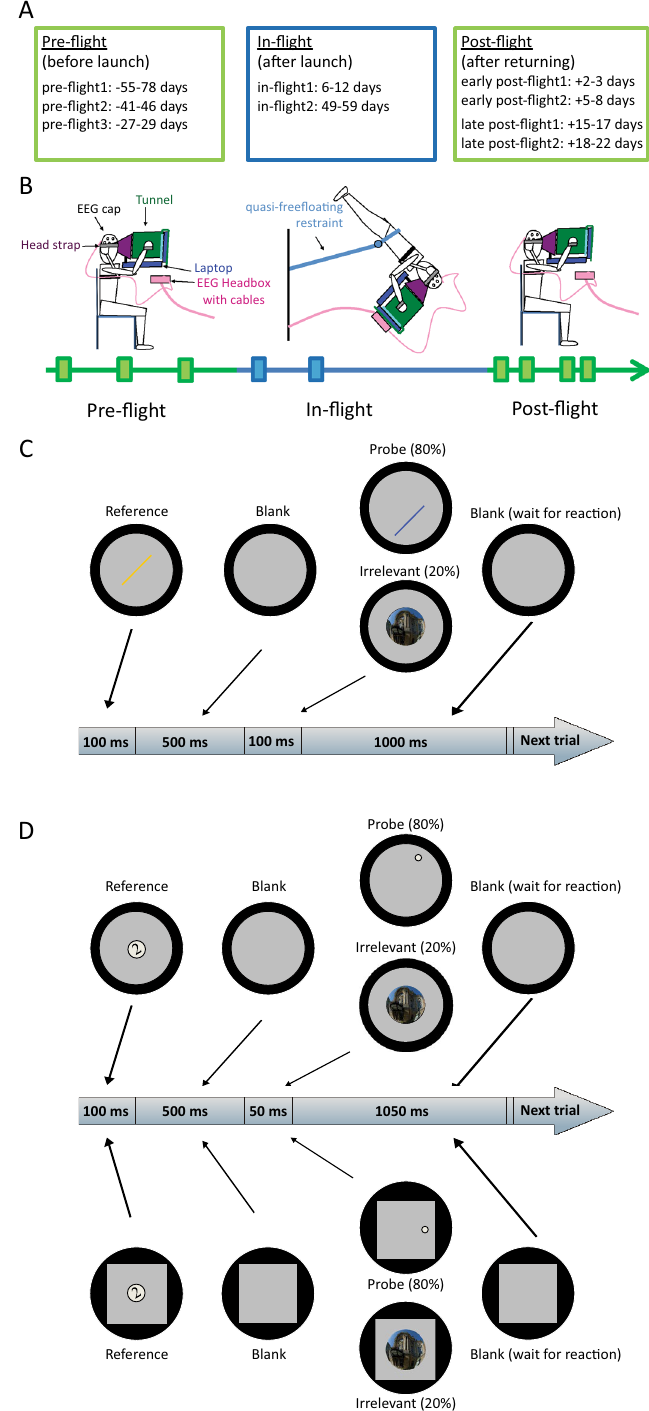
Figure 1. Schematic timeline of study design and the two tasks. ( A ) Schedule of data collection. ( B ) During pre-flight and post-flight, participants performed the experimental tasks in a seated position, watching a computer screen through a facemask attached to a cylindrical tube. On orbit, subjects performed the experiment in a quasi free-floating posture, holding on to the tunnel-computer complex that floated with the subject with the facemask held securely to the head with a strap. ( C ) Stimulus presentation in the Lines task. Participants had to indicate whether two successively presented lines (Reference and Probe stimuli) had the same orientation. 20% of the Probe stimuli were replaced by a task-irrelevant picture (Irrelevant stimulus). ( D ) Stimulus presentation in the Clock task. Participants had to indicate whether the spatial location of a dot (Probe stimulus) matched the clock time represented by a digit (Reference stimulus). Half of the trials were presented in a square frame (Frame condition, shown below), while the other half were presented inside a circular border (NoFrame condition, shown above). The square frame served to provide an oriented visual reference, as the circular tunnel excluded all external visual